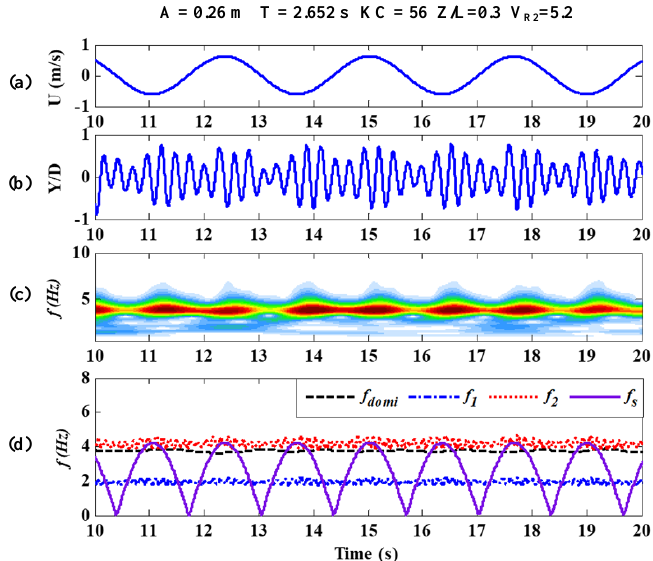
Figure 11. The time history of the VIV response and time–frequency distribution at Z/L = 0.3 for V R2 = 5.2 and KC = 56: ( a ) The forced motion velocity; ( b ) The VIV displacement response; ( c ) The time–frequency distribution of the VIV response; ( d ) The time-varying frequencies.